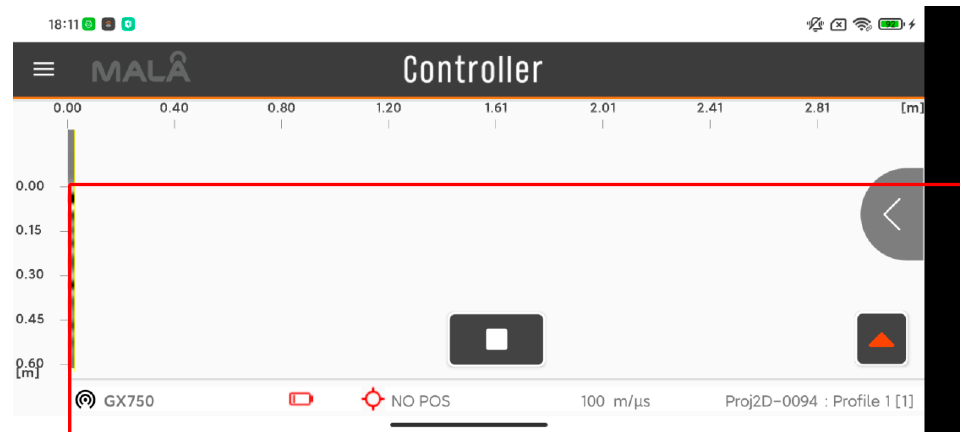
Figure 11. Reconstructed image pixel coordinate map.